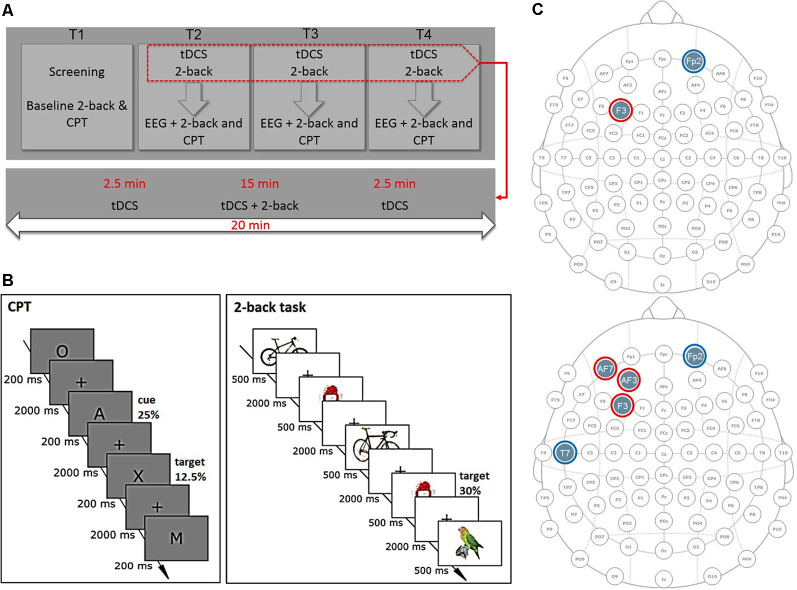
Experimental design. (A) Time-course of the experiment. Each participant attended four sessions. At screening and baseline sessions (T1), we assessed inclusion and exclusion criteria and task baseline performance. At stimulation sessions (T2–T4), participants were stimulated for 20 min with consecutive 2-back task performance. After stimulation, electroencephalography (EEG) at rest and during task performance was recorded. (B) Tasks. In the 2-back task, participants had to decide whether a currently presented picture was identical to the picture shown two steps back. In the continuous performance task (CPT), participants had to press the space bar every time the letter A was followed by the target letter “X” and withhold their response for all other letters. (C) Electrode montages for bipolar stimulation (top) and multichannel stimulation (bottom). Red circles represent anodal; blue circles reference electrodes.